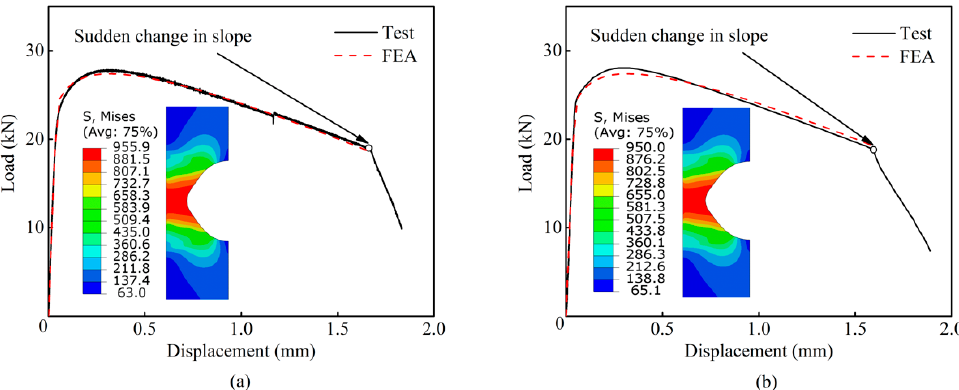
Figure 7. Numerical results of X80 pipeline steel for the SNT tensile specimens (R = 3.2 mm): ( a ) Specimen M3; ( b ) Specimen M4.